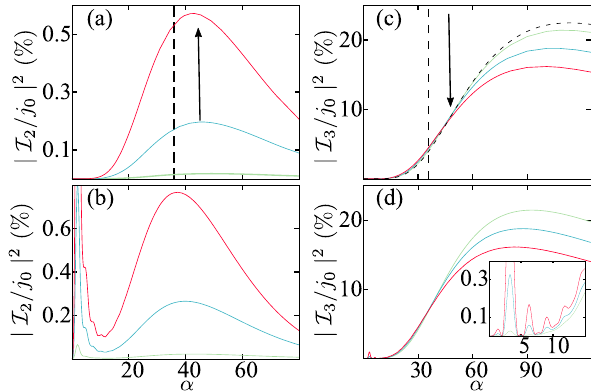
Figure 2: (Color online) Comparison of the nonlinear response ( ν )| 2 characterizing the generation of second [panels (a) and (b)] | I l and third [panels (c) and (d)] harmonics. The curves are calculated using either the path integral approach of Eq. (3) [(a) and (c)], or the ansatz of Eq. (19) [(b) and (d)] as a function of the parameter α (cid:2) eE / ( h ν ) and different values of the asymmetry coef fi cient ac d δ (cid:2) 1 . 05 , 1 . 2 , 1 . 4. The dashed curve (c) indicates the usual third harmonic at δ = 1 whereas the vertical dashed lines [(a) and (c)] designatesthecritical fi eld ( a (cid:2) a c ) forwhichtheSSLcanoperatein the NDC part of the VI characteristic. The inset zooms on numerical instabilities for | I 3 ( ν )| 2 with small parameter α in the third harmonic. In all cases the frequency of the oscillating fi eld is ν (cid:2) 141